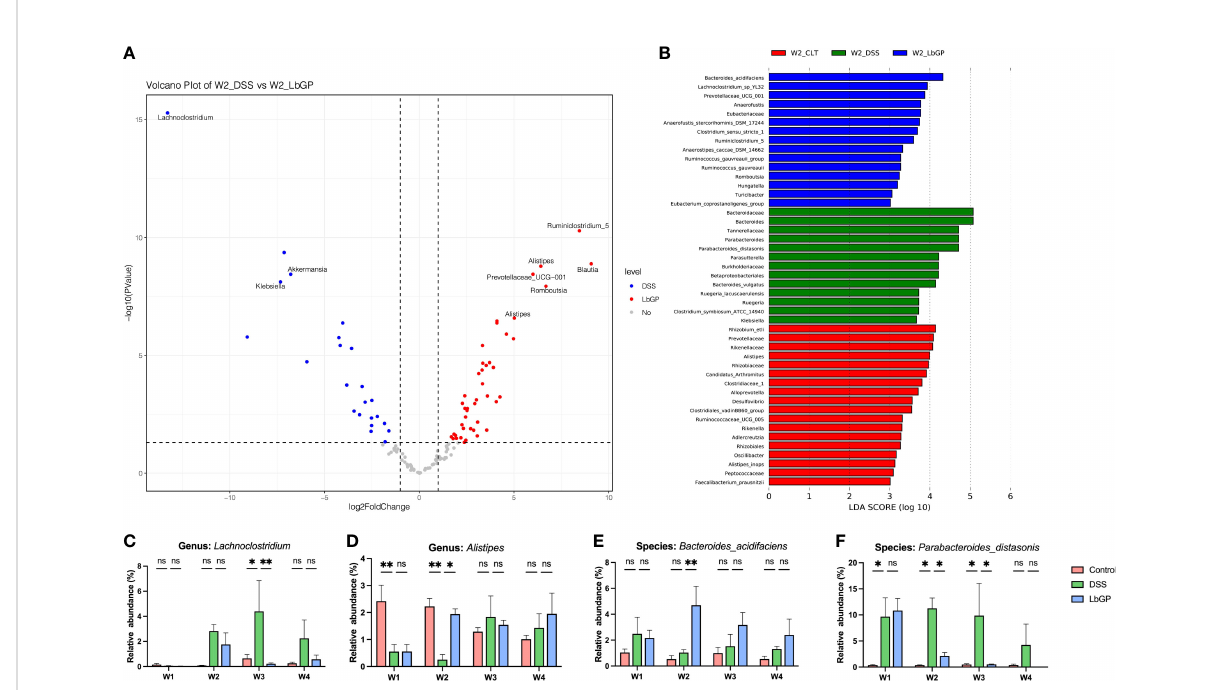
FIGURE 5 Identi fi cation of microbiota biomarker during the development of acute colitis and LbGP treatment. (A) Volcano plot of differential OTUs between the DSS group and LbGP group at W2. (B) LEfSe analysis among the three groups at W2 with the highest linear discriminant analysis (LDA) score (lg (LDA score) ≥ 3). (C, D) Relative abundance of Lachnoclostridium and Alistipes. (E, F) Relative abundance of Bacteroides_acidifaciens and Parabacteroides_distasonis (n = 5, *P < 0.05, **P < 0.005). “ ns ” means “ no signi fi cant ”